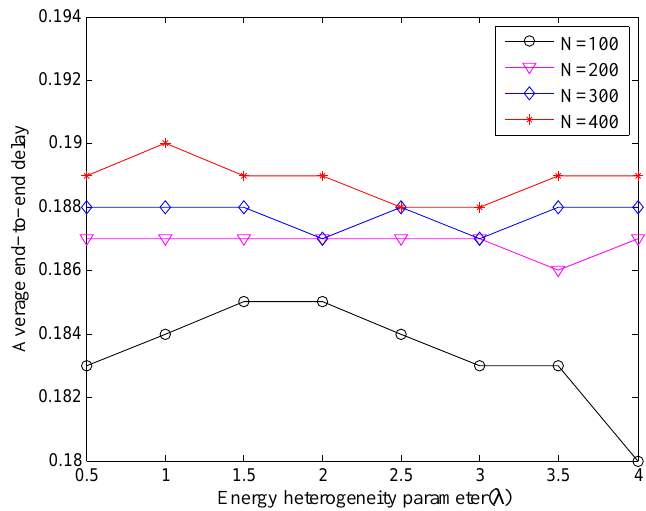
Figure 5. The average end-to-end delay (s) under different energy heterogeneity